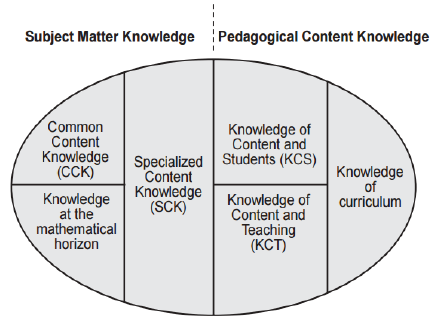
Figure 2. The MKT model of Ball et al. [13].